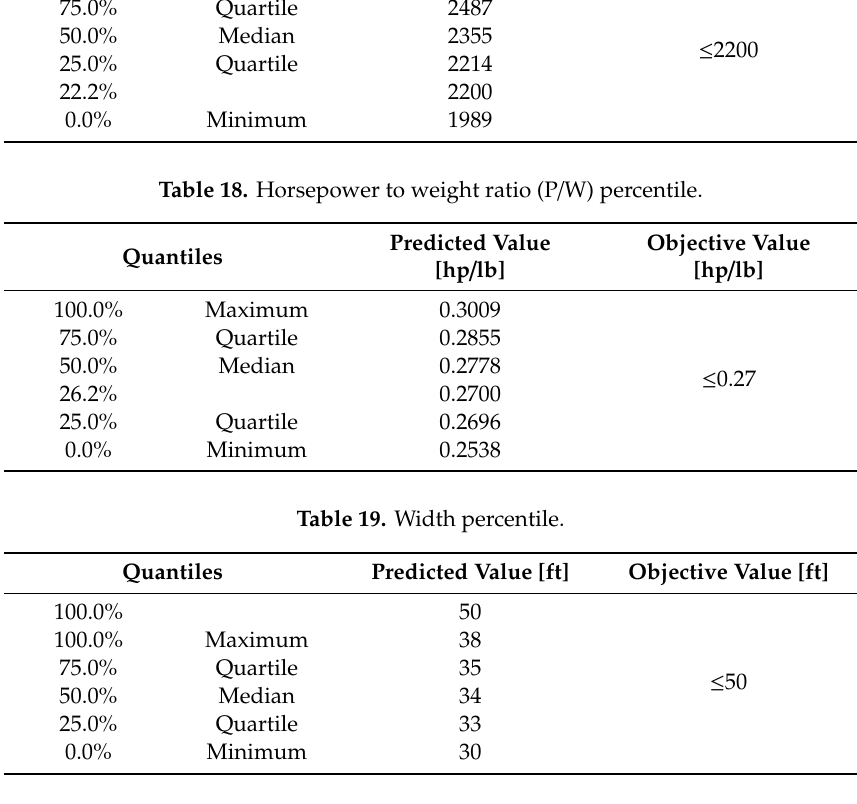
Table 17. Maximum takeoff weight (MTOW) percentile.